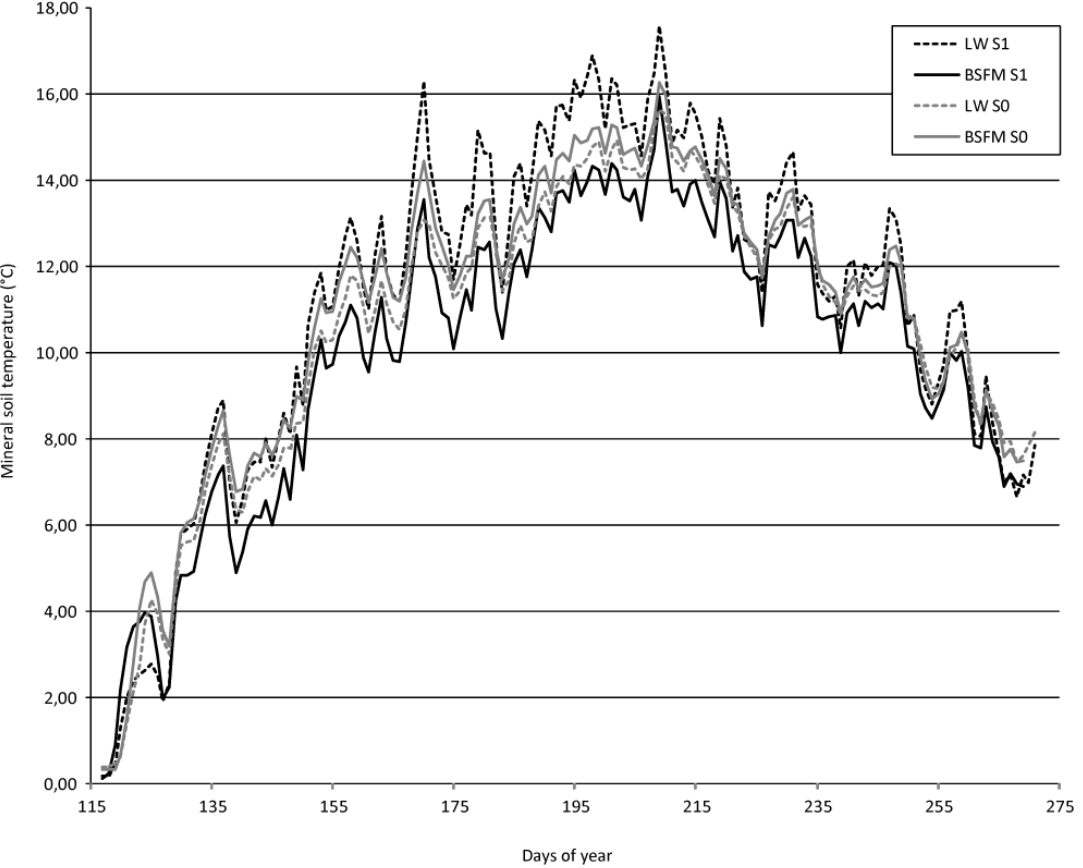
Figure 6. Mineral soil temperature (°C, 10 cm deep) in scarification furrows (S1) and skid trail (S0) of harvested and scarified lichen woodlands (LW) and black spruce feather-mosse (BSFM)